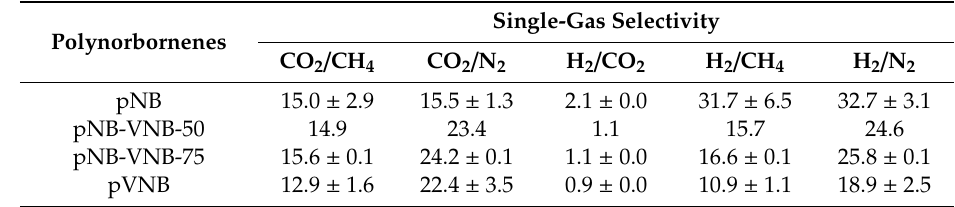
Table 5. Ideal selectivity of polynorbornenes with increasing VNB content.